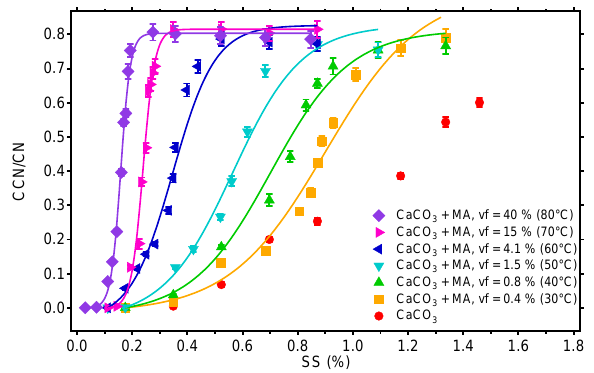
Figure 6. Activated fractions (CCN / CN) of monodisperse CaCO 3 aerosol particles (with CaCO 3 core, d u = 101 . 9nm) at different su- persaturations before (red circles) and after malonic acid (MA) coat- ing. With increasing coating, i.e., MA volume fraction (vf), the ac- tivated fraction, and thus CCN activity, increases compared to bare CaCO 3 particles. All coated particles can be activated at sufficiently high SS and SS crit and κ was determined (see Table